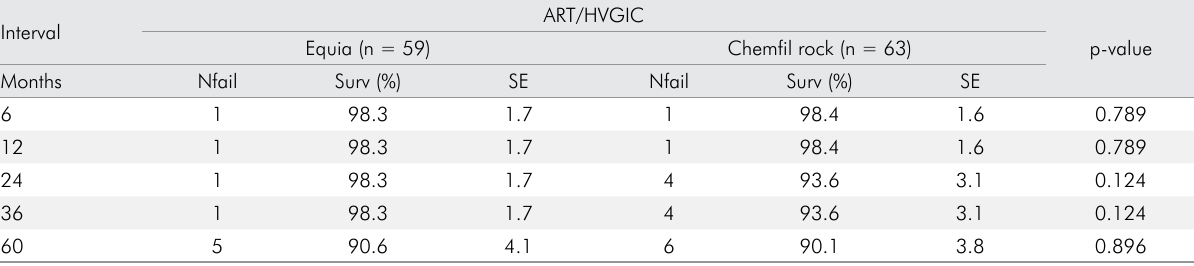
Table 3. Cumulative survival percentages and Jackknife standard error (SE) of ART restorations in permanent teeth of patients